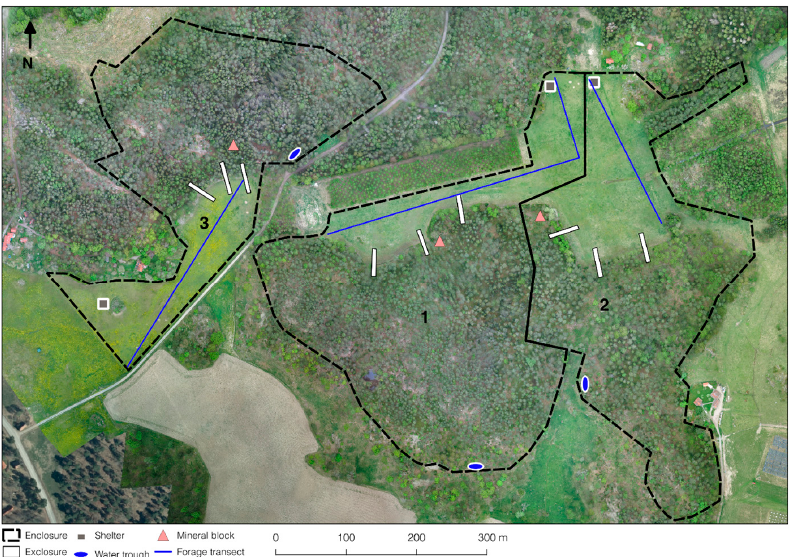
Figure 1. Aerial view of the three enclosures (1, 2, and 3) used in the study, showing position of shelters, water troughs, mineral blocks, exclosures, and pasture transects. Photo taken on 24 May 2016 at 150 m altitude.